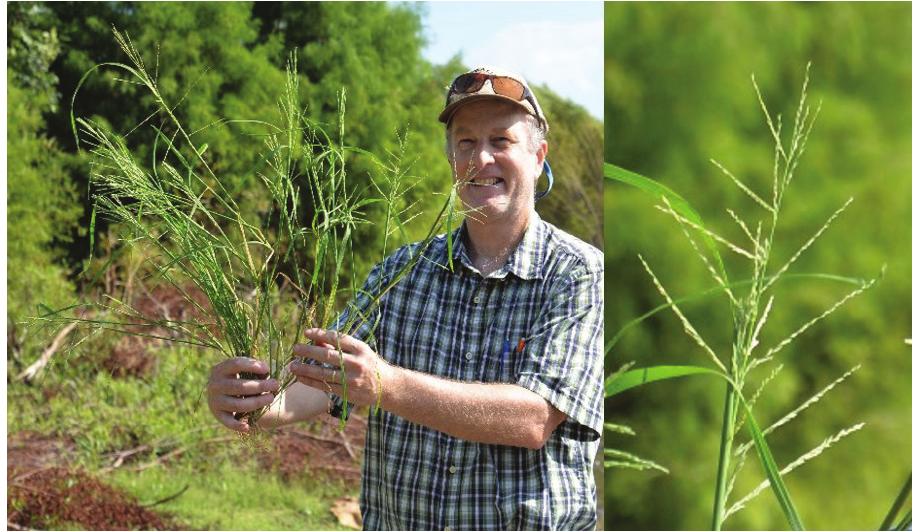
Figure 5 Typical growth form (left) of Diplachne fusca subsp. fascicularis (Montgomery Co., Kansas; Snow 10978 [KSP]). As typical for the subspecies, it has fewer, longer, and more widely spaced panicle branches (right) than L. f. subsp. uninervia , with one or more of the lower panicle branches enclosed in the uppermost leaf